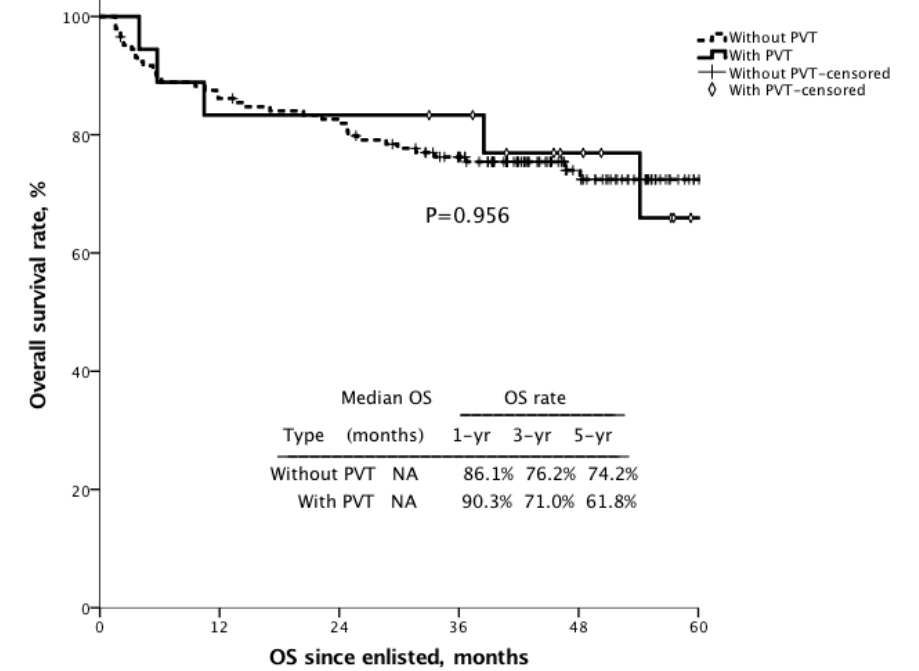
Figure 1. The Kaplan–Meier survival curve of the transplant recipients with or without PVT. The 1 year, 3 year and 5 year survival after transplantation for the patients with PVT were 90.3%, 71.0%, and 61.8%, compared with 86.1%, 76.2%, and 74.2% for the patients without PVT ( p = 0.956).